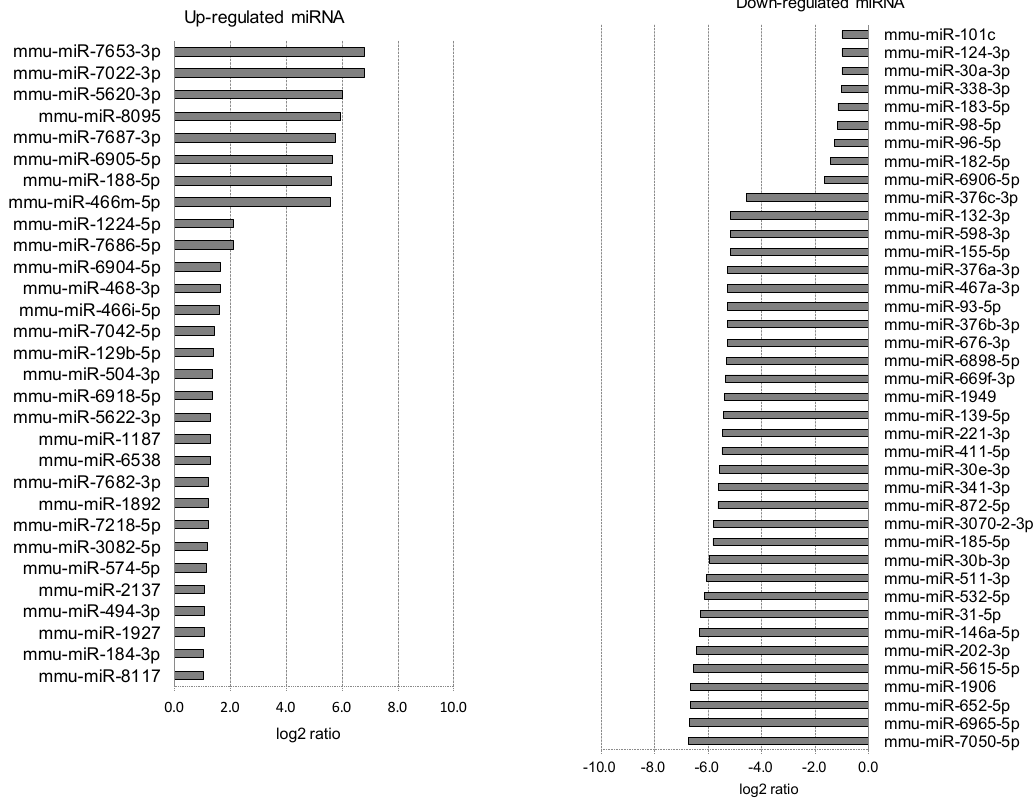
Figure 9. Scleral miRNAs affected by myopia induction. The scleral miRNAs whose expression was affected by myopia induction are listed as upregulated ( left ) and downregulated ( right ).